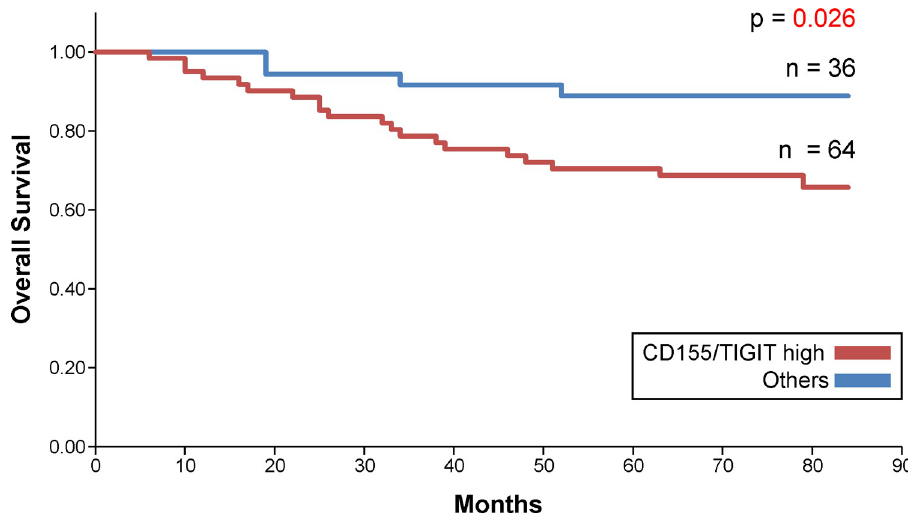
Fig 7. Overall survival curve for CD155 and